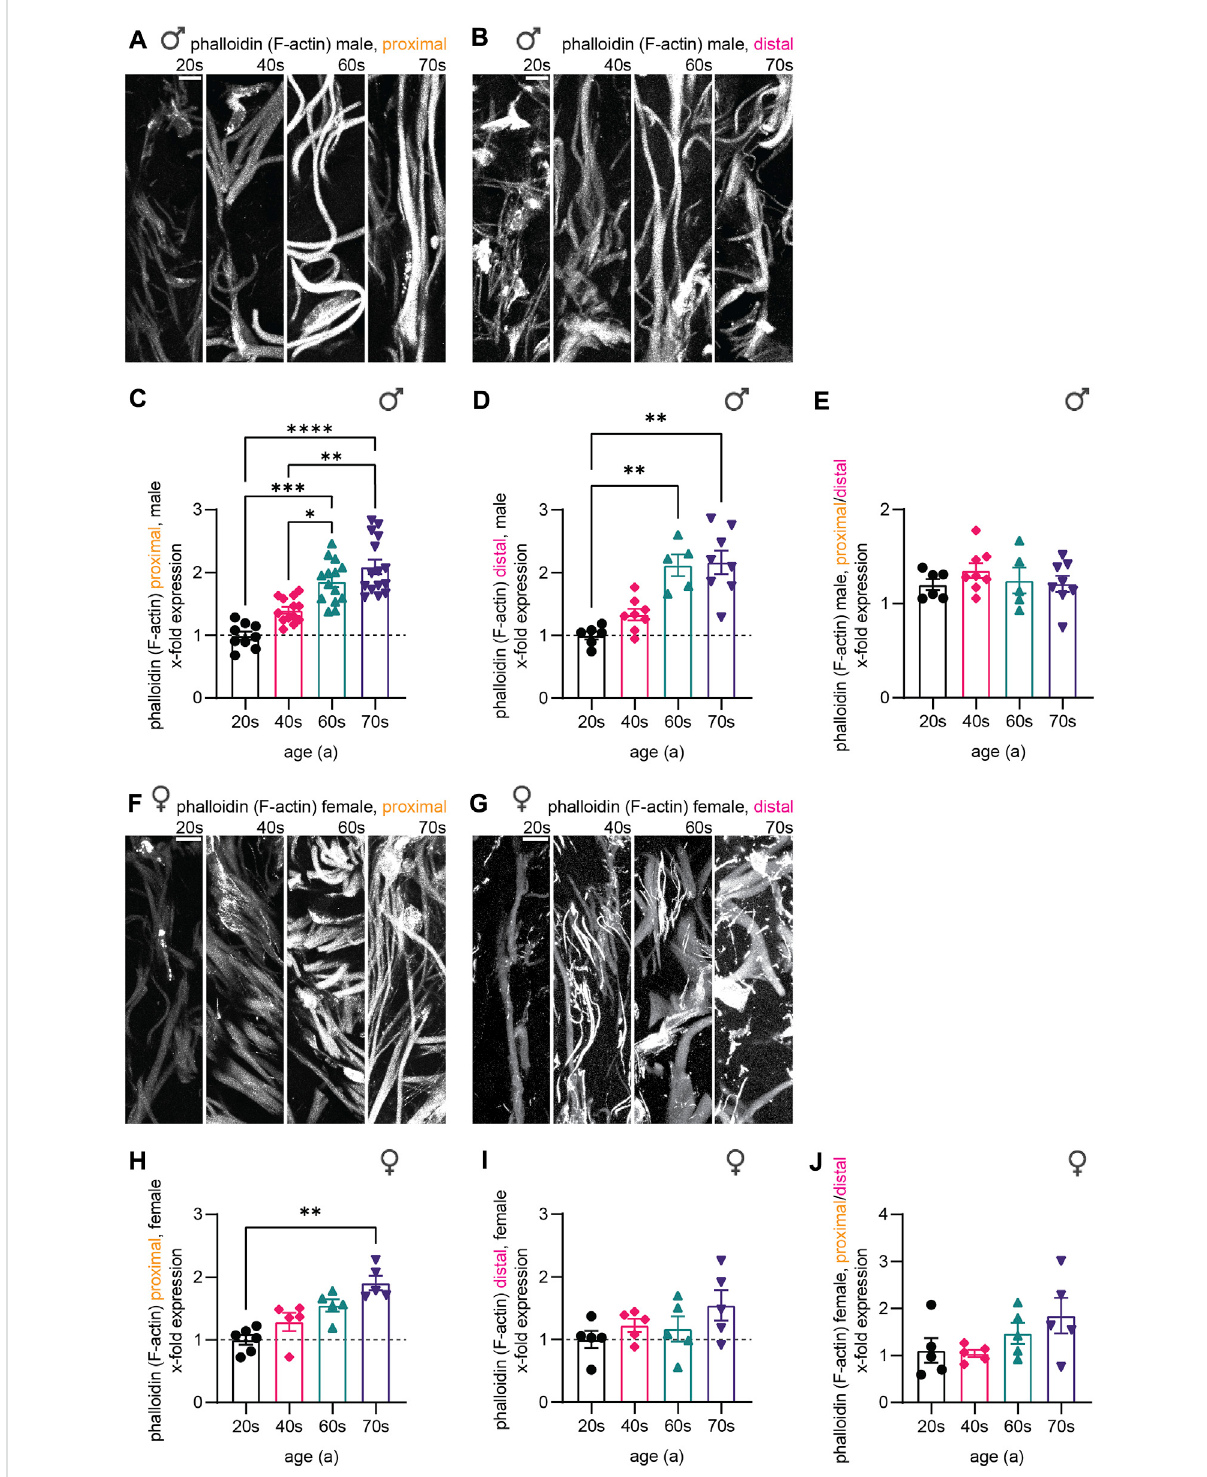
FIGURE 5 Quantitative immunostaining of human skin sections for phalloidin. (A,B,F,G) Phalloidin labeling (white) for the (A) male proximal, the (B) male distal, the (F) female proximal, and the (G) female distal samples of the four age groups (20s, 40s, 60s, and 70s). (C,D,H,I) Quantitative analysis con fi rmed these results for each respective data set (x-fold normalized to average of 20s group) (3 images per individual, ≤ 20 axons per image, (C) n =51individualsinproximalmale, (D) n =27indistalmale, (H) n =21inproximalfemale, (I) n =20indistalfemaledata). (E,J) Phalloidinintensity ratio between the male and female proximal and distal samples allowed to compare both sample sets. Scale bars in (A,B,F,G) are 10 µm. Points in graphs (C,D,H,I) represent on individuals. Data represent mean ± SEM. Kruskal – Wallis test with Dunn ’ s multiple comparisons test. * p < 0.05, ** p < 0.01, *** p < 0.001, **** p <